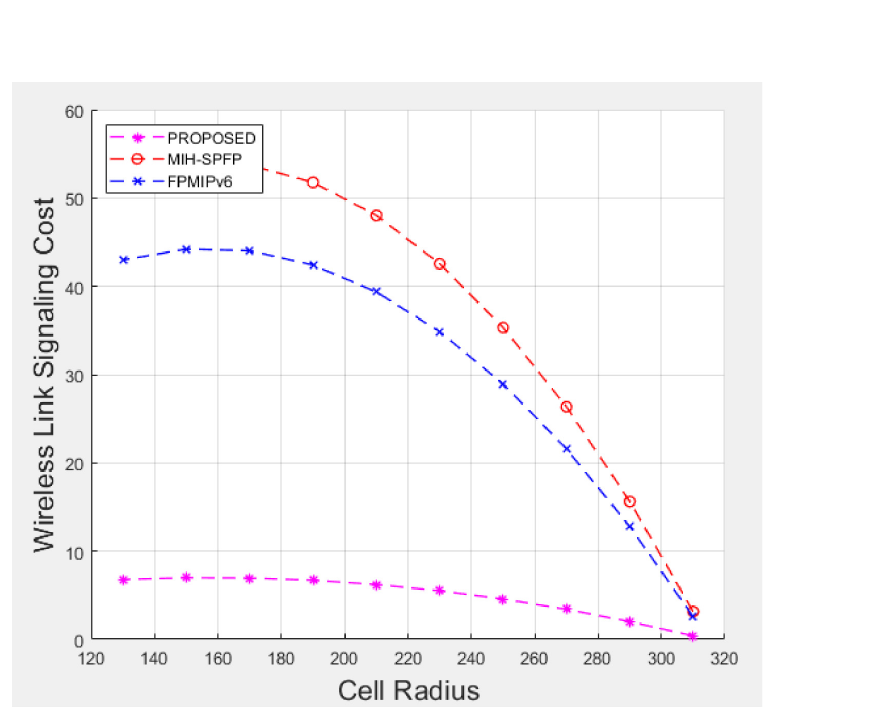
Fig 11. Wireless failure probability vs wireless link signaling